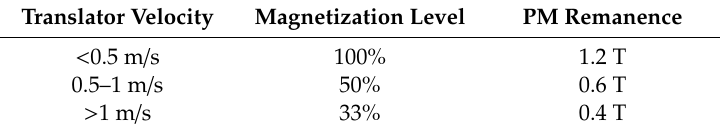
Table 2. Flux regulation strategy.